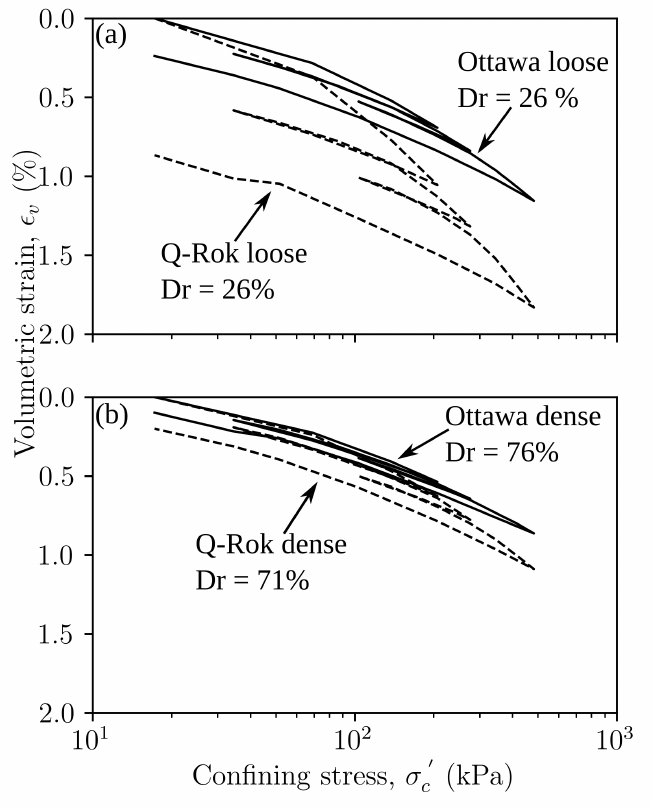
Figure 10. Isotropic consolidation of ( a ) loose, and ( b ) dense specimens of Ottawa sand and